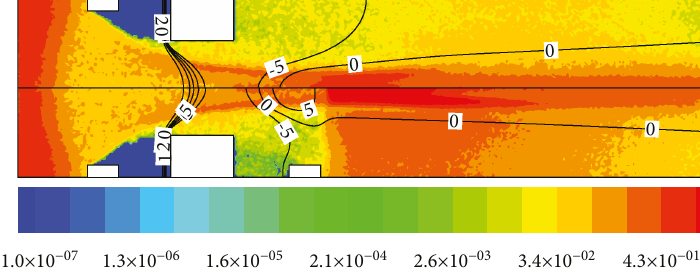
Figure 13: CEX ions and potential distribution at n